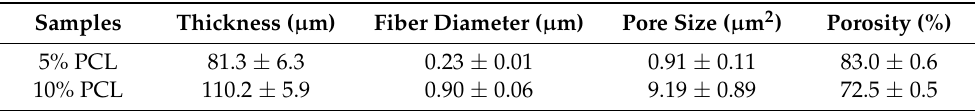
Table 1. Physical dimensions of poly ( ε -caprolactone) nanofiber